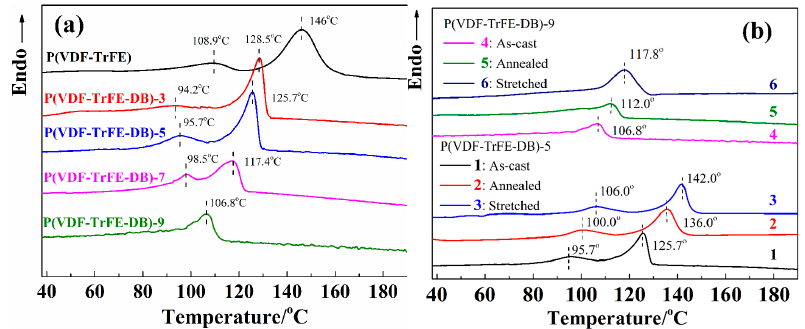
Figure 3. DSC curves of the as-cast P(VDF-TrFE) (80/20 mol %) and P(VDF-TrFE-DB)s with different composition ( a ), and P(VDF-TrFE-DB)-5 and P(VDF-TrFE-DB)-9 with different treatment conditions ( b ). Table 2. The crystallization characterization data of the copolymer films.